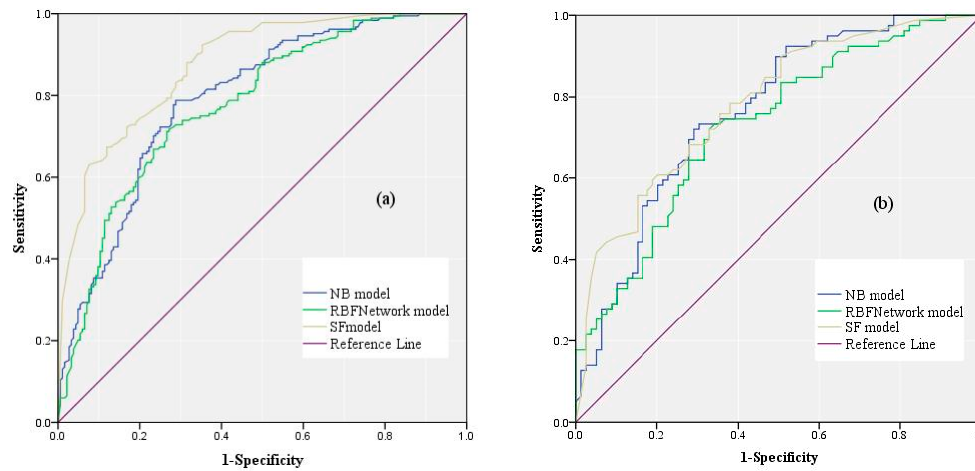
Figure 8. ROC curves of the models: ( a ) training dataset, ( b ) validation dataset. Table 2. Parameters of ROC curves with the training dataset. CI: confidence interval.